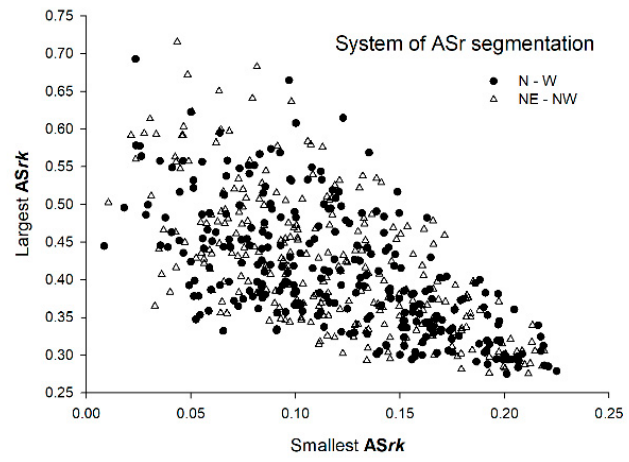
Figure 6. Graphically established tree growing space according to the orientation extremes of tree social area (AS). The smallest AS rk represents the lowest relative value of the ninety-degree sector AS. The largest AS rk represents the highest relative value of the ninety-degree sector of AS. Table 2. Observed median and extremes of relative tree social area segments (AS rk ), ( n = 279).